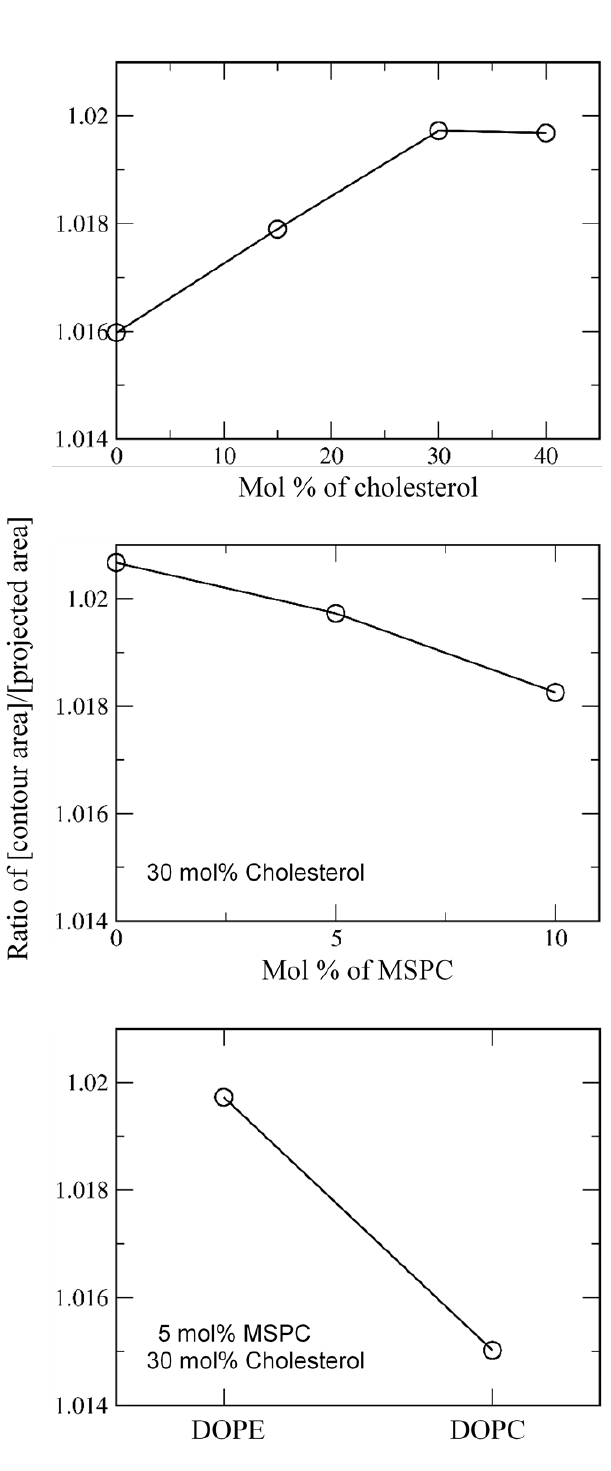
Figure 5. The ratio of [contour bilayer-surface area]/[projected bilayer-surface area] as functions of cholesterol ( top ), MSPC ( middle ), and lipid type (DOPE vs. DOPC; bottom ).